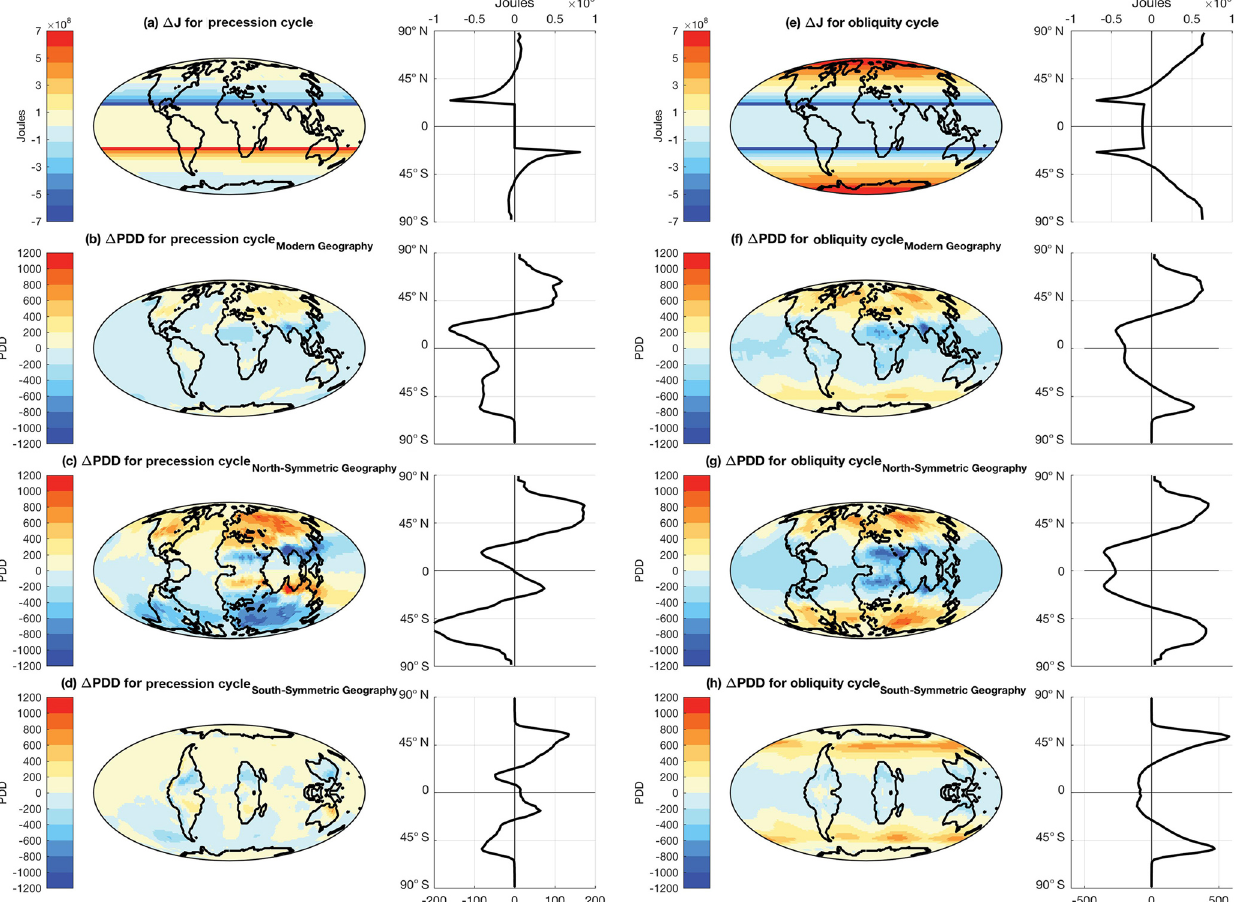
Figure 5. Summer energy (J) change for a transition from a SHSP to a NHSP orbit (a) ; and the corresponding change in positive degree days (PDD) in CONTROL (b) ; NORTH-SYMM (c) and SOUTH-SYMM (d) simulations. Summer energy (J) change for a transition from LOW to HIGH orbit (e) ; and the corresponding change in PDD in CONTROL (f) ; NORTH-SYMM (g) and SOUTH-SYMM (h) simulations.